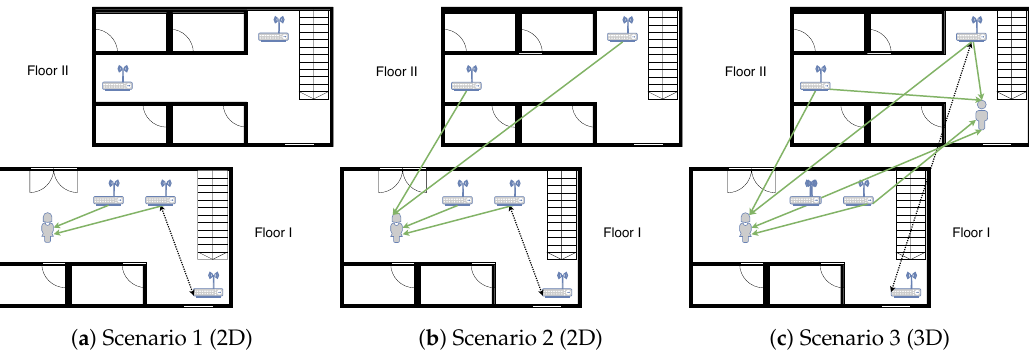
Figure 2. Testing scenarios. ( a ) Localisation using APs from the current floor, horizontal location of APs is changed. ( b ) Localisation using APs from all floors, horizontal location of APs is changed. ( c ) Localisation using APs from all floors, horizontal and vertical location of APs is changed. The green arrows indicate the AP used for the localisation process, the dotted arrow shows an AP